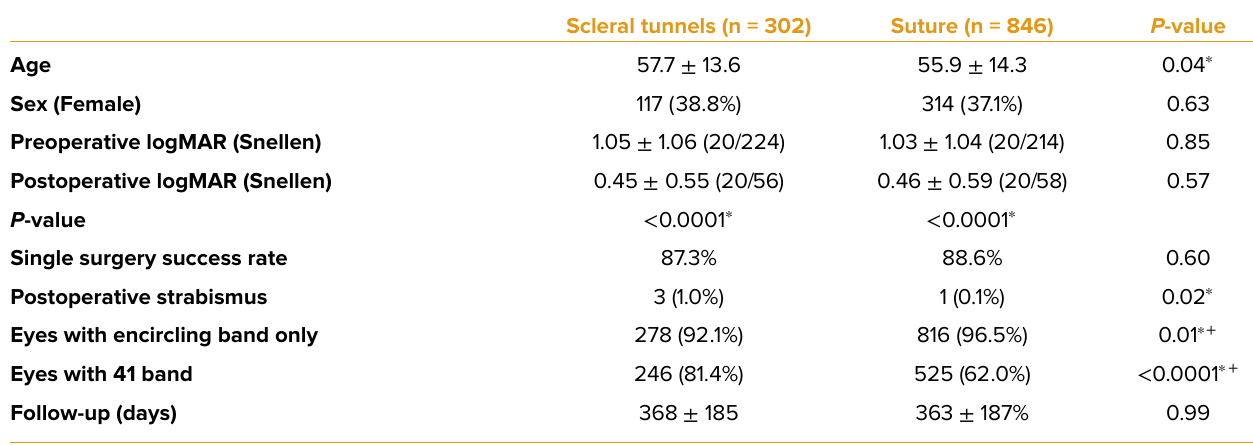
Table 1. Demographics and visual and anatomic outcomes comparing scleral tunnels versus scleral sutures in fixation of scleral buckle during retinal detachment surgery for both scleral buckle surgery and pars plana vitrectomy combined with scleral